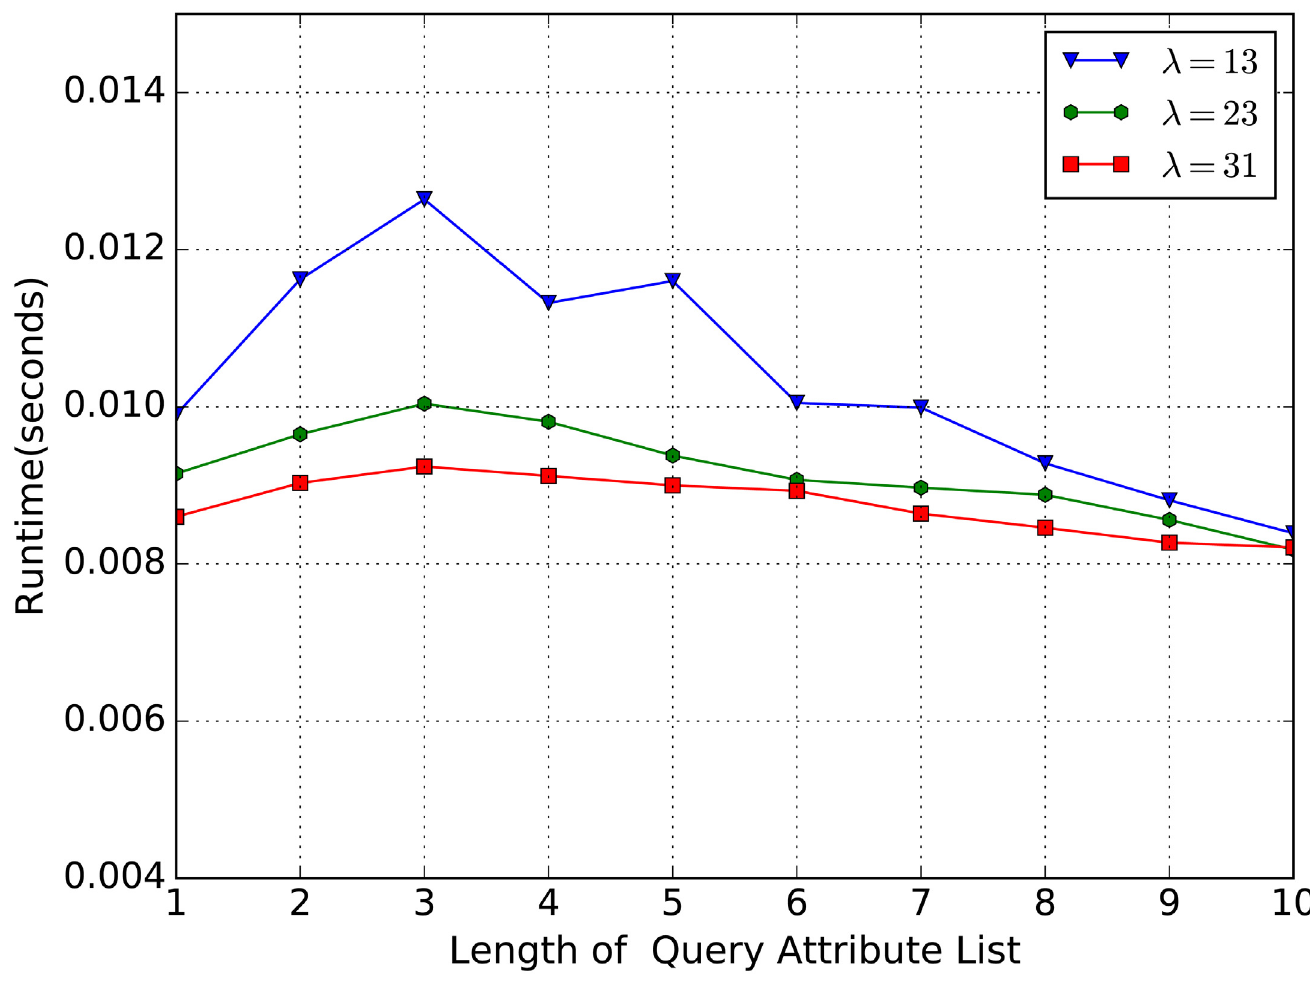
Fig 7. The integrated test